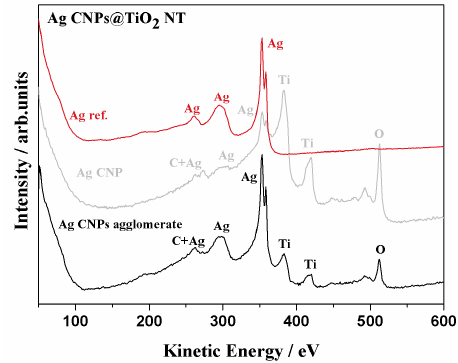
Figure 8. Auger local spectra taken for identification of the chemical composition from a single Ag nanoparticle (gray) and from an Ag agglomerate (black). For comparison, an Ag MNN reference spectrum for metallic Ag is given (red).